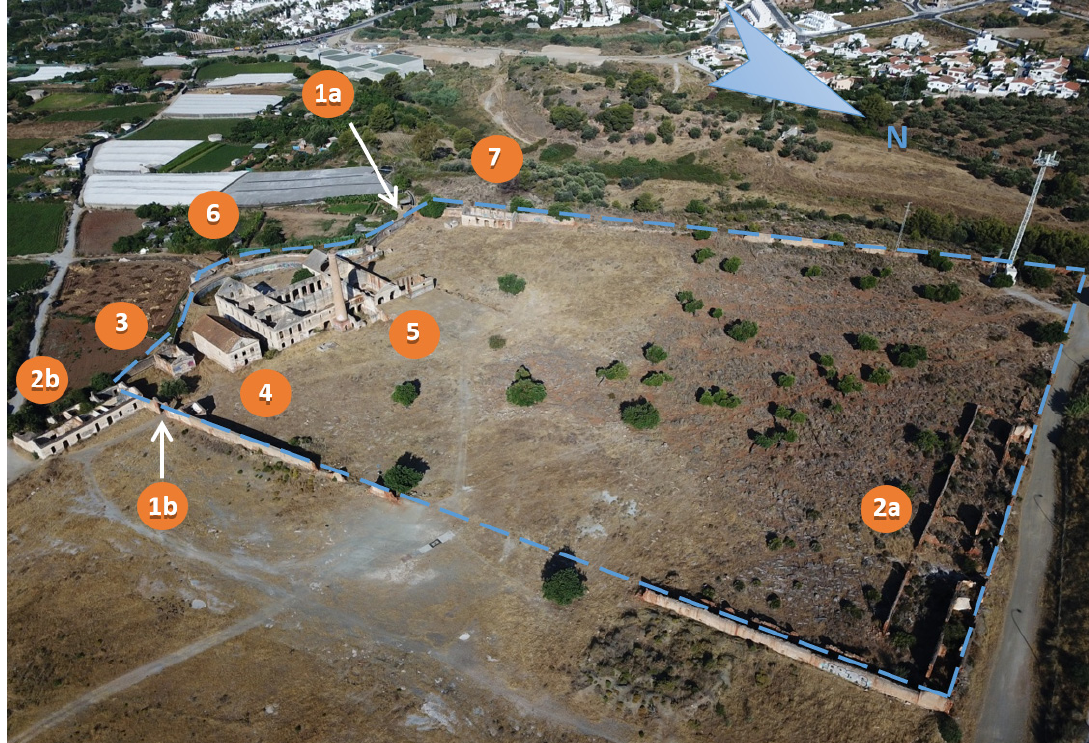
Figure 4. Factory elements distribution. Aerial image obtained in the UAV flight operation.